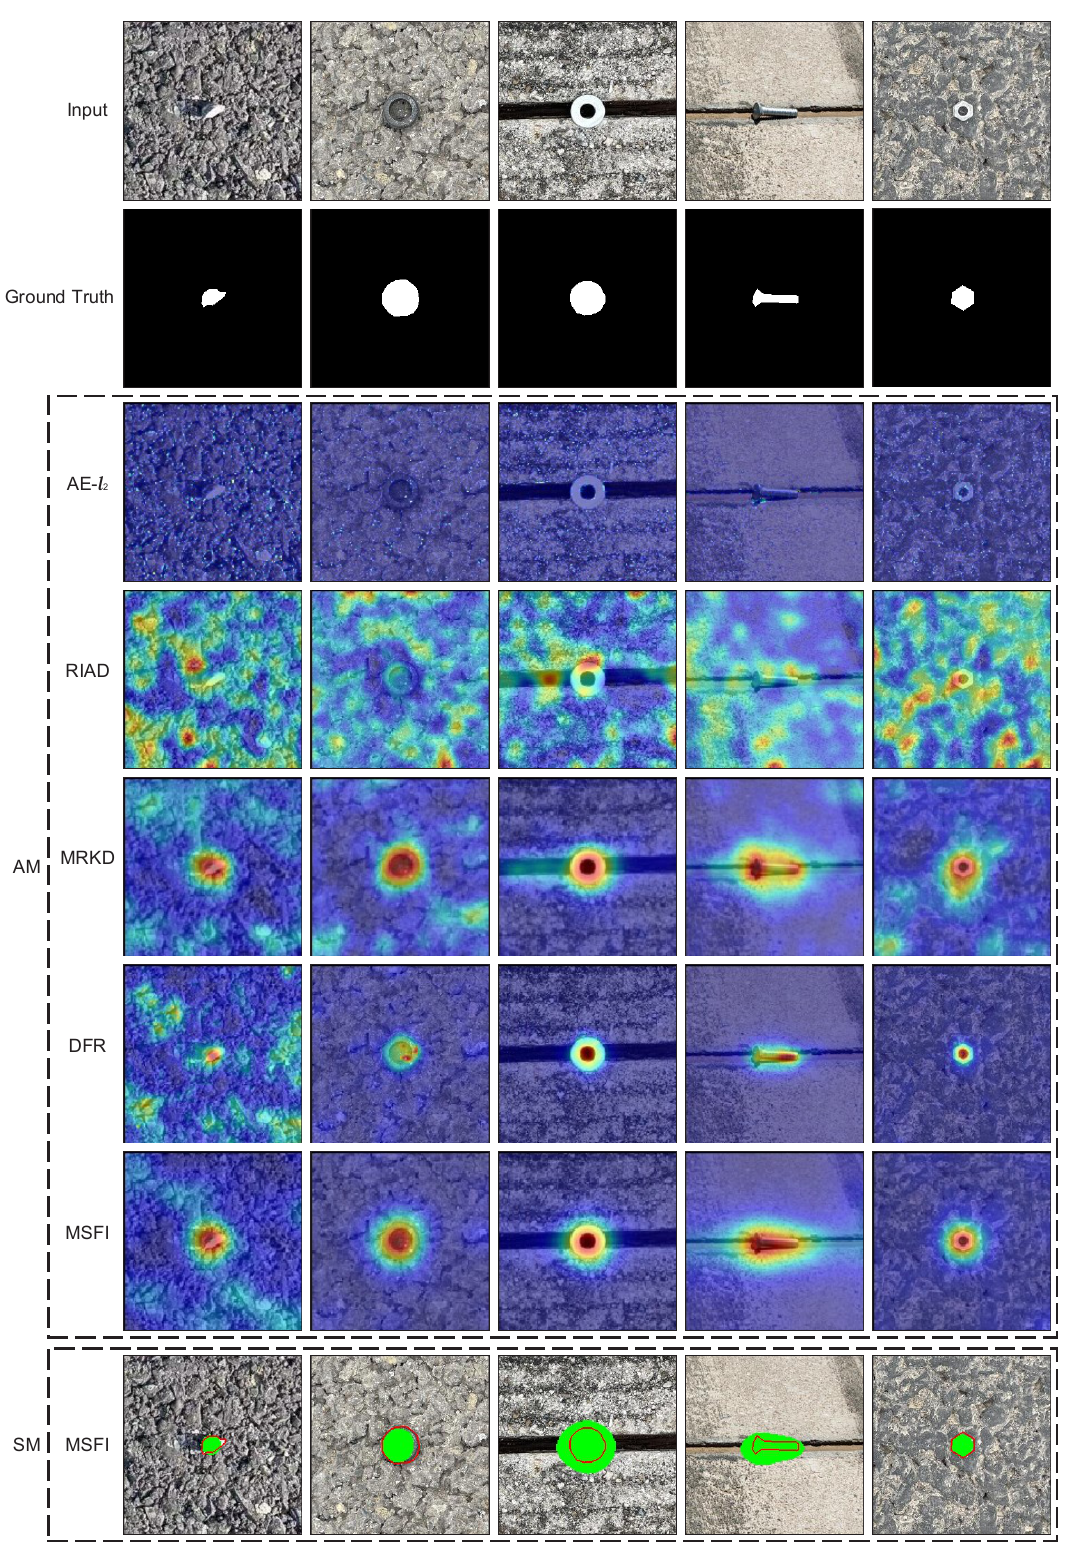
Figure 6. Qualitative comparison between the proposed method and other methods on FOD dataset. Input represents the input abnormal image. Ground Truth represents the actual abnormal regions (in white). AM represents the anomaly map. SM represents the segmentation map. The red region represents the high anomaly score of AM, the solid red line indicates the boundary of the actual abnormal region and the green region represents the predicted abnormal region in